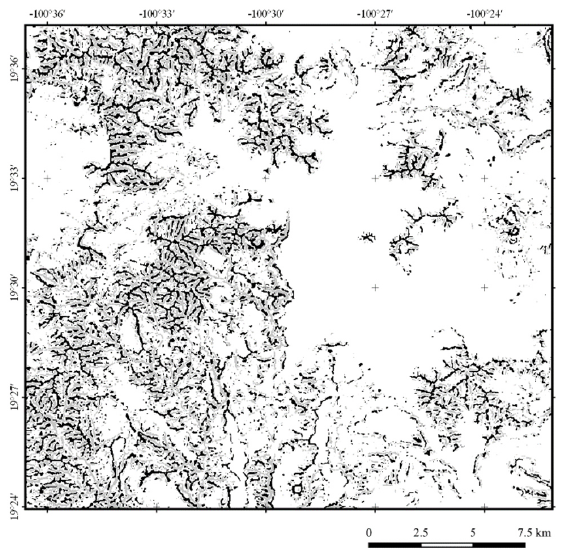
Figure 13 . Black crest lines (0-110) and grey riverbeds (145-255) inside roughness zones.